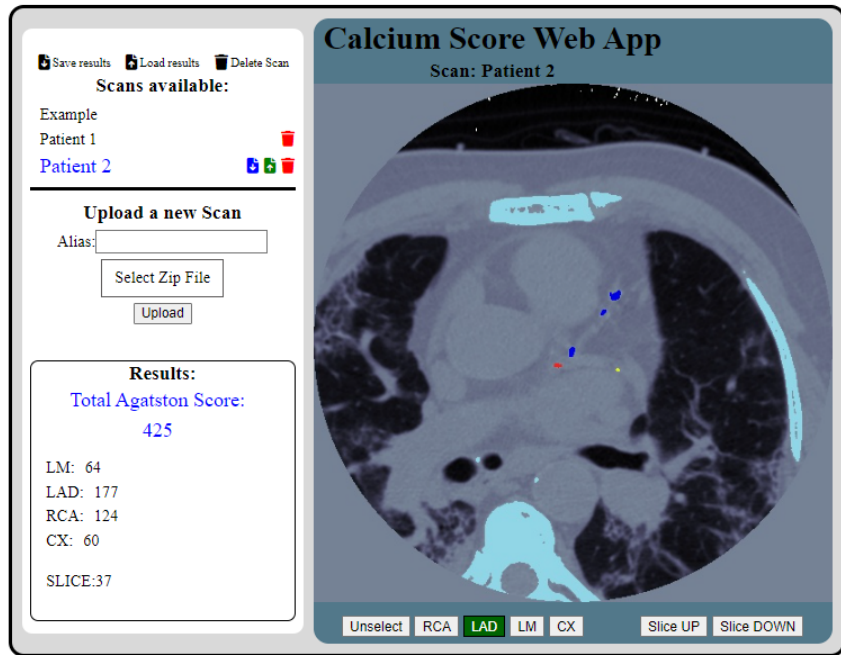
Figure 11. Example of home page with two scans